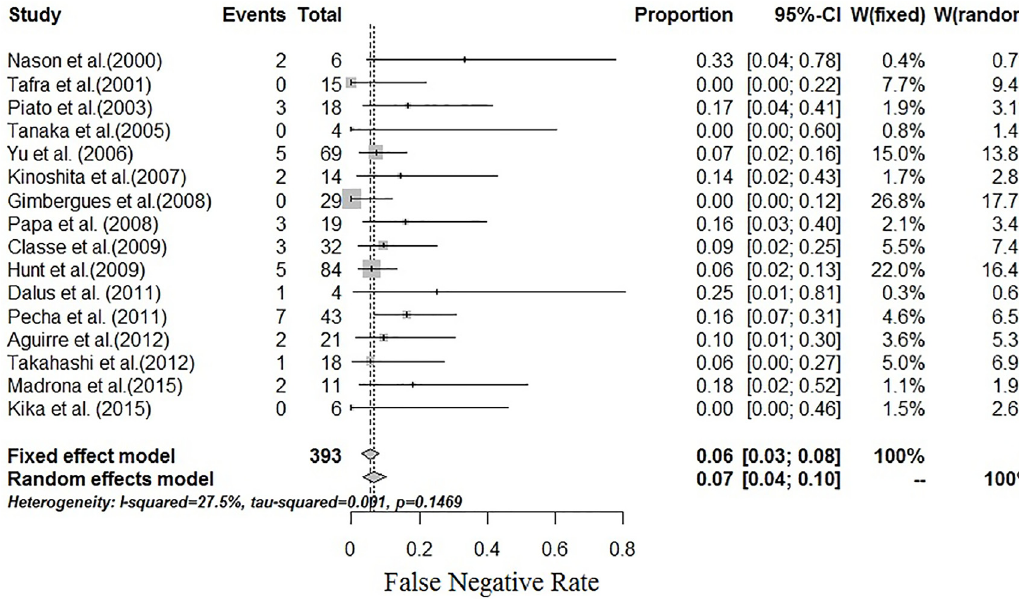
Fig 4. Forest plot of the FNR. A fixed-effects model was used to estimate the combined FNR with a result of 6% (95% CI: 3%-8%) I 2 =